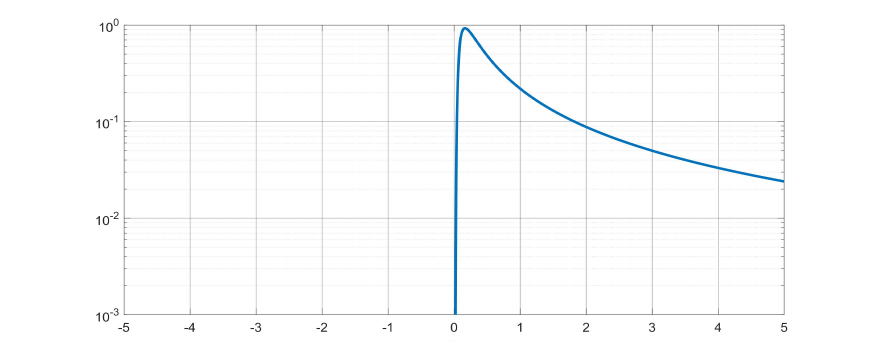
Figure 3. Plot of the unilateral extremal stable pdf for α = 1/2.